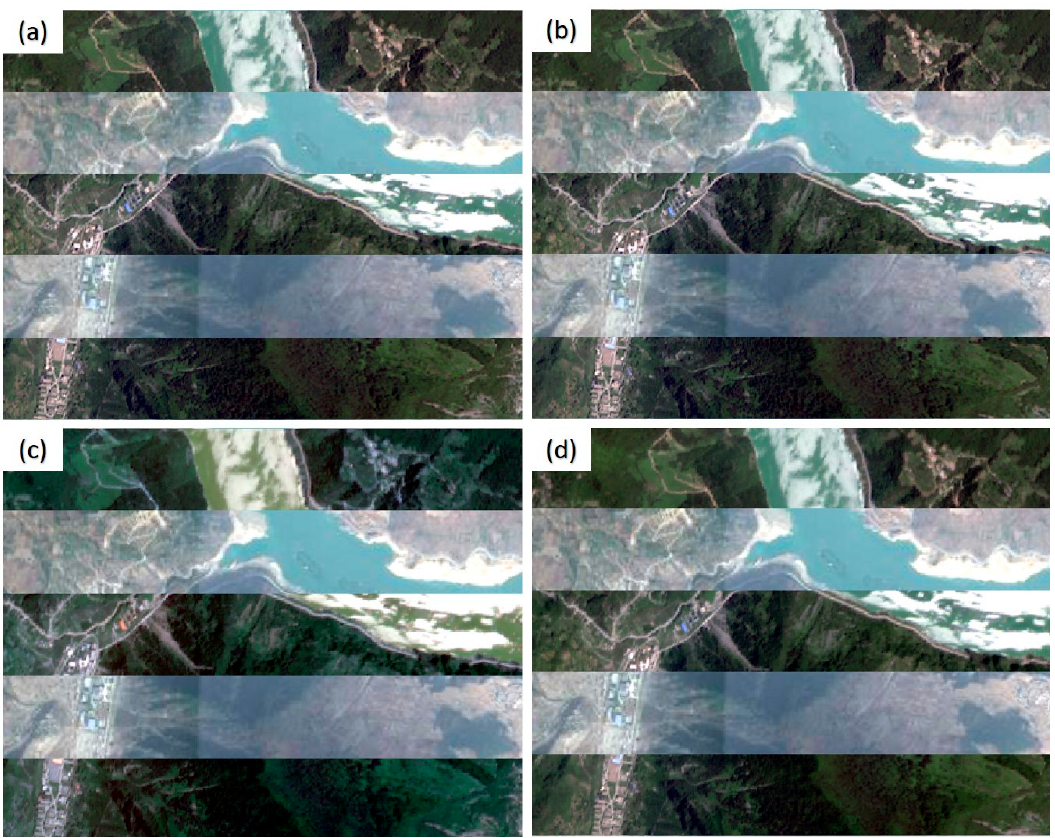
Figure 14. Registration results of the Yaan dataset. ( a ) The original image; ( b ) registered image of the proposed method; ( c ) registered image of Patch-SIFT; and ( d ) registered image of SIFT. Sensors 2020 , 20 , x FOR PEER REVIEW